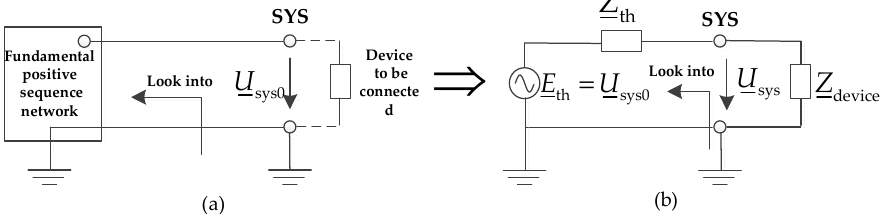
Figure 6. Thevenin equivalence principle of a power grid: ( a ) before the device is connected to the grid; ( b ) after the device is connected to the grid.